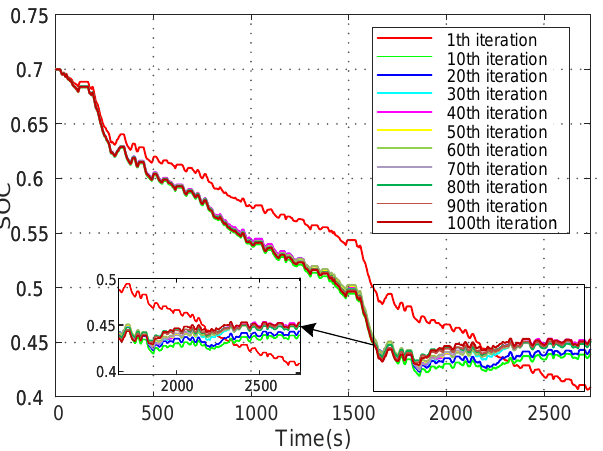
Figure 12. SOC trajectories with different iterations.